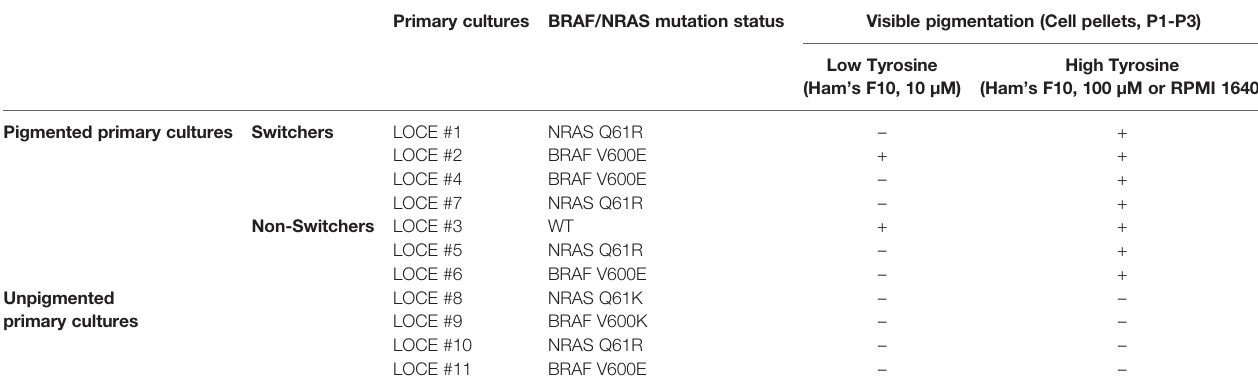
TABLE 1 | List of melanoma primary cultures used in the study and their classi fi